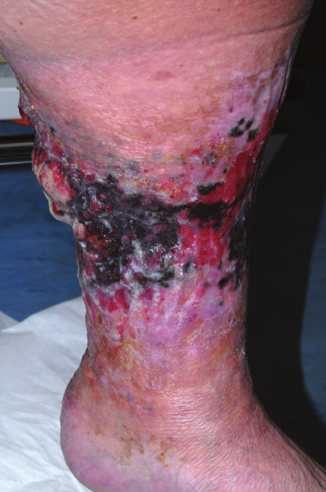
F 1: Circumferential malignant melanoma to the le lower leg demonstrating its